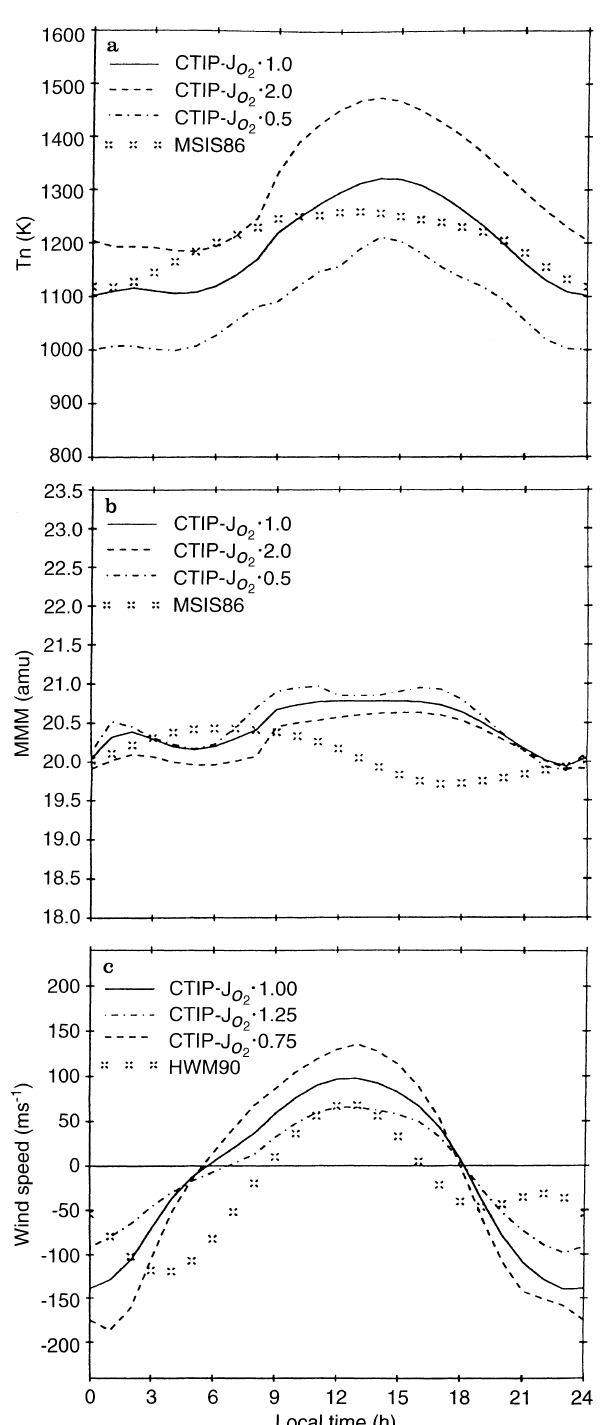
Fig. 10a–c. The sensitivity of a T n ; b mmm and c V x (positive polewards), at 300 km over Argentine Islands, to changes in the magnitude of the O 2 photodissociation